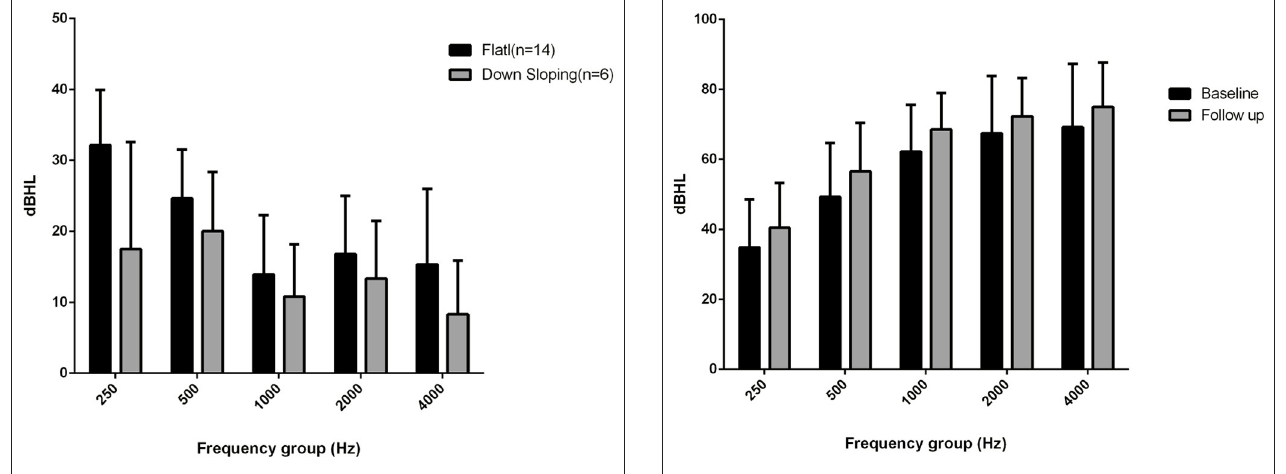
at the last follow-up and the baseline threshold was 5.95 dB (confidence interval of 0.7–14.10, p for mean = 0.018, p for each frequency range 250–4,000 Hz < 0.05). The partial and total values of the baseline and last follow-up BC thresholds are shown in Table 1 .